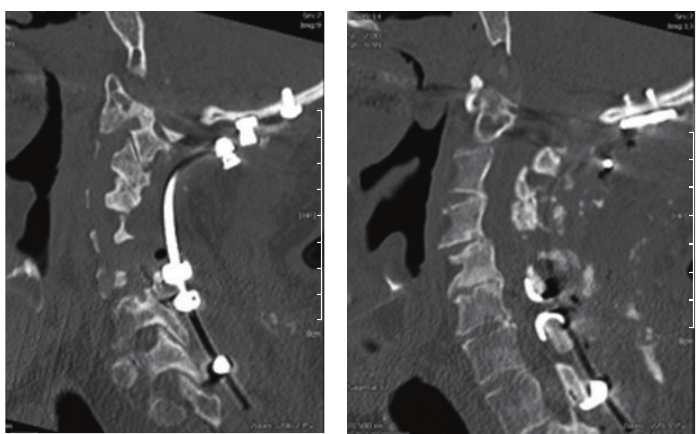
Figure 5: Occipitocervical fixation showing a double claw construct at C4/5 and C6/7 using sublaminar hooks.